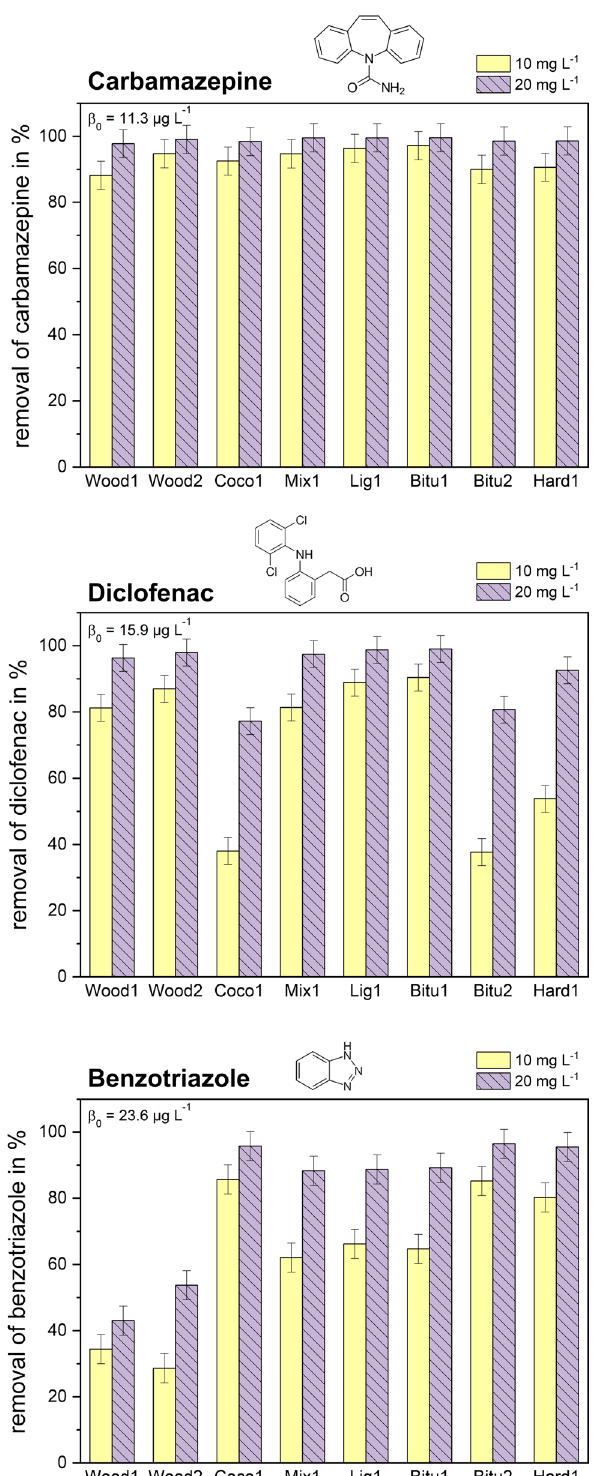
Fig. 9 Selected removals of carbamazepine, diclofenac and ben- zotriazole in treated wastewater for the eight PACs, each dosed as − 1 − 10 mg L and 20 mg L